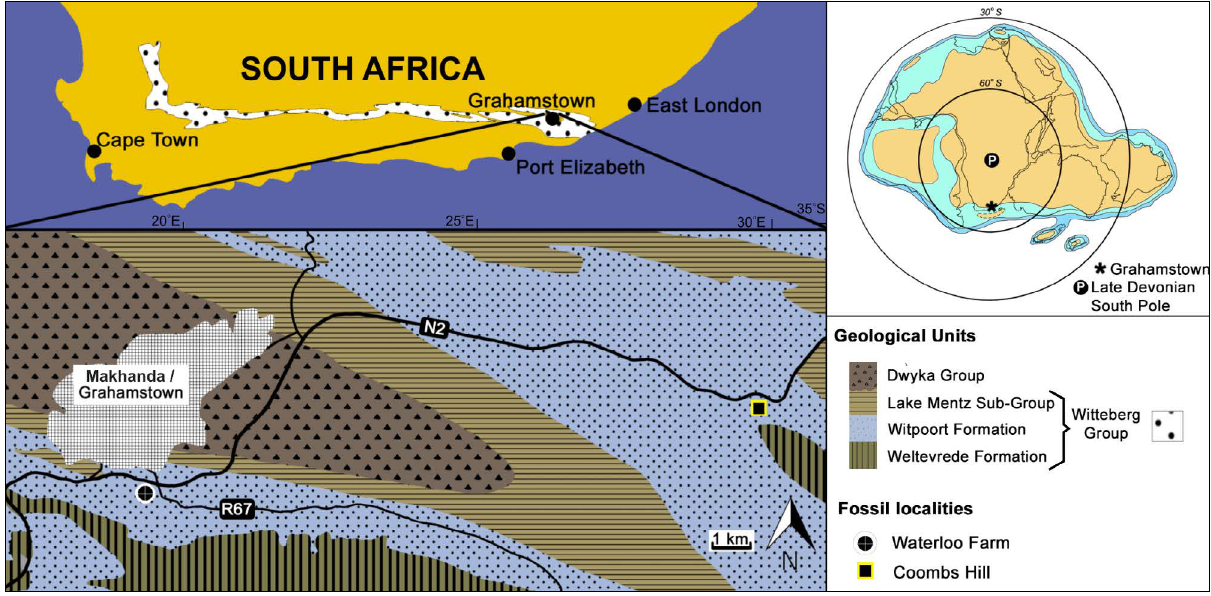
Figure 1: Geological map of the Makhanda (Grahamstown) region (based on Council for Geoscience, Grahamstown sheet 3326 (1995)), showing the locations of fossil localities at Waterloo Farm and Coombs Hill. A key to stratigraphic units is provided at the bottom right. Palaeogeographic reconstruction of Late Devonian Gondwana (top right) modified from Gess and Ahlberg 3 .